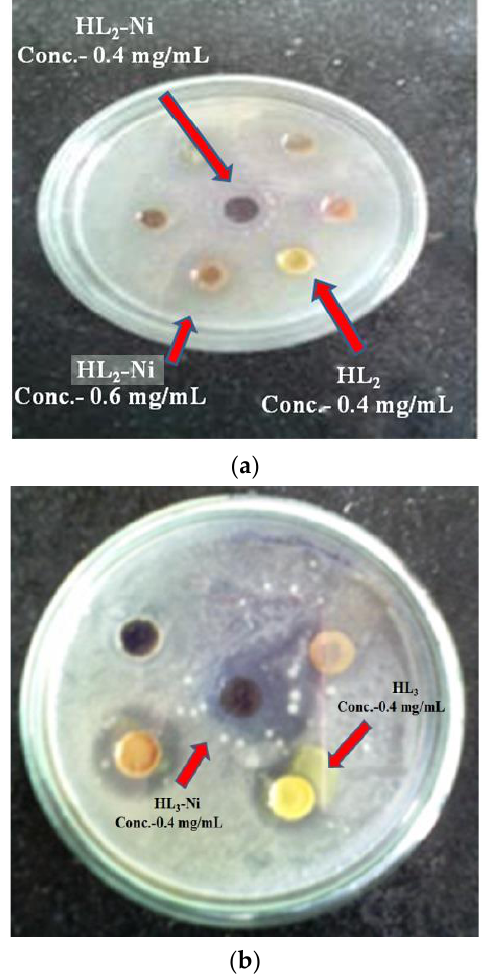
Figure 2. ( a ) Zone of inhibition of HL 2 and HL 2 -Ni for Pseudomonas aeruginosa; ( b ) Zone of inhibition of HL 3 and HL 3 -Ni for Staphylococcus aureus. of HL 3 and HL 3 -Ni for Staphylococcus aureus